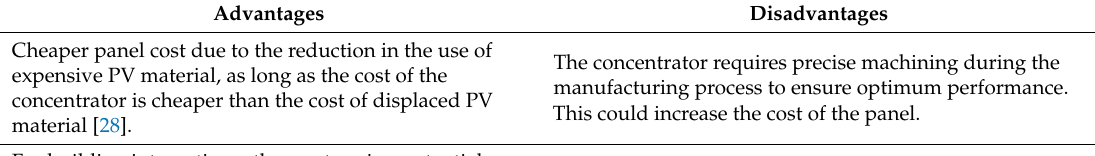
Table 1. The advantages and disadvantages of using a building integrated concentrating photovoltaic (BICPV)